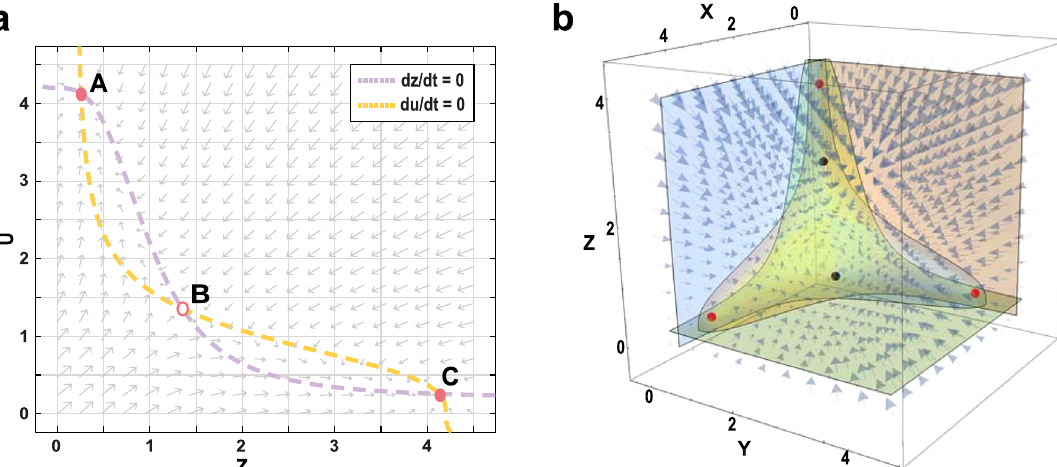
Fig. 2 Realisation of tristability by embedding two bistable sub-systems. a The phase plane of the toggle switch sub-system (1) with bistability (A and B: stable steady states, C: saddle state). b The 3D phase portrait of the embedded system (3) with tristability (Three red points: stable steady states; two black points: saddle